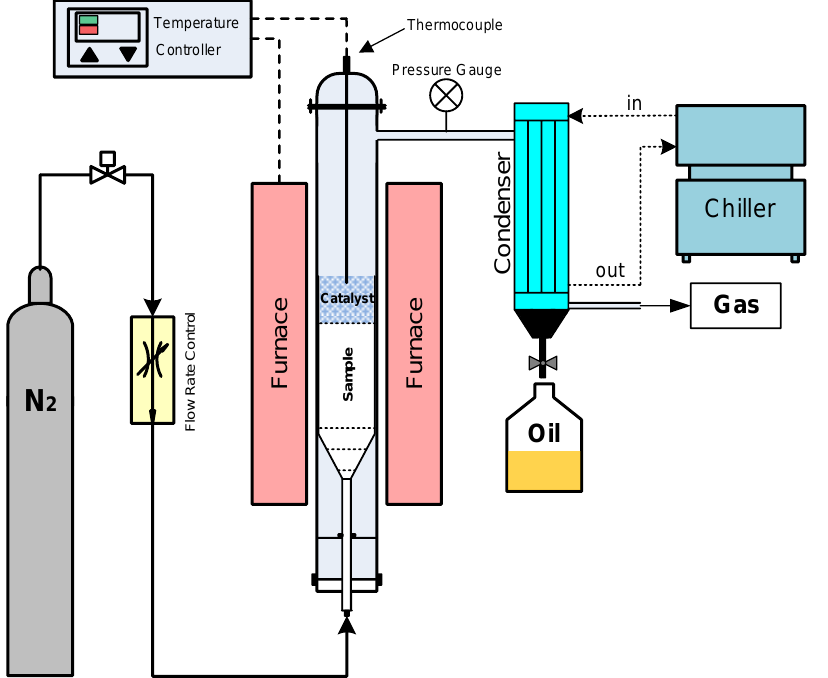
Figure 1. Schematic diagram of the experimental setup for pyrolysis of plastic mixtures.